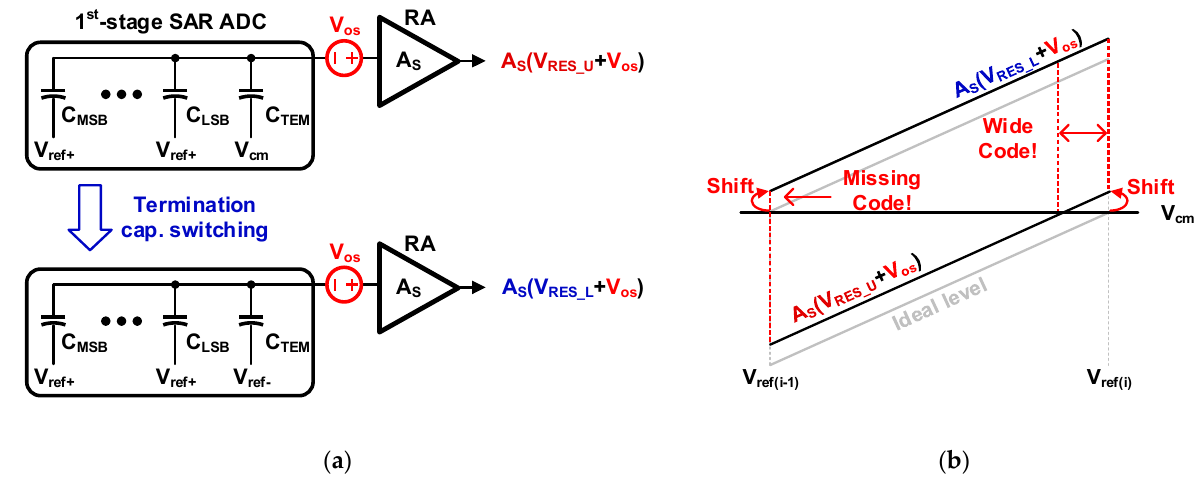
Figure 7. Non-idealities in the proposed architecture: ( a ) Schematic with the residue amplifier offset mismatch; ( b ) Residue profile.